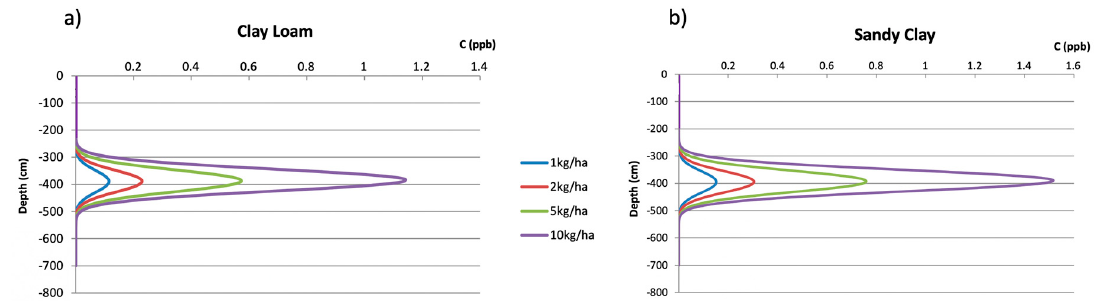
Figure 5. PESTAN terbuthylazine concentrations at t=2000 days for two types of soil and different single dose concentrations. a) Clay-loam. b) Sandy-clay.